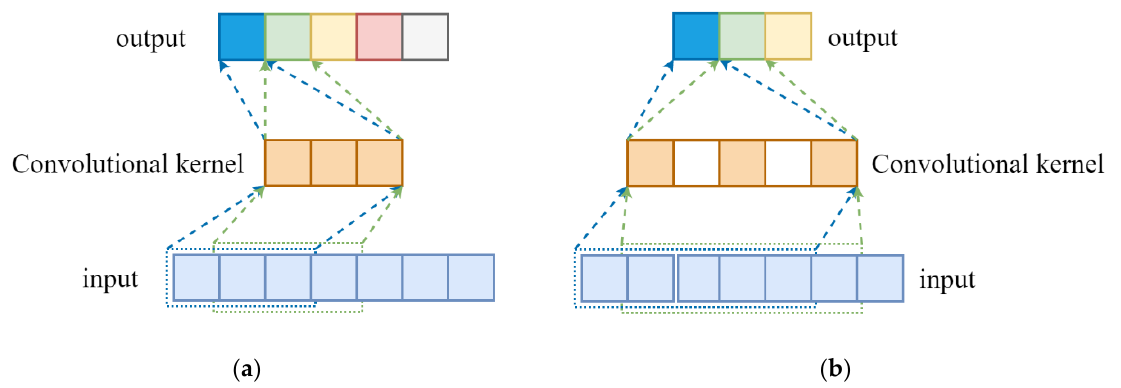
Figure 1. Basic structure of CNN.